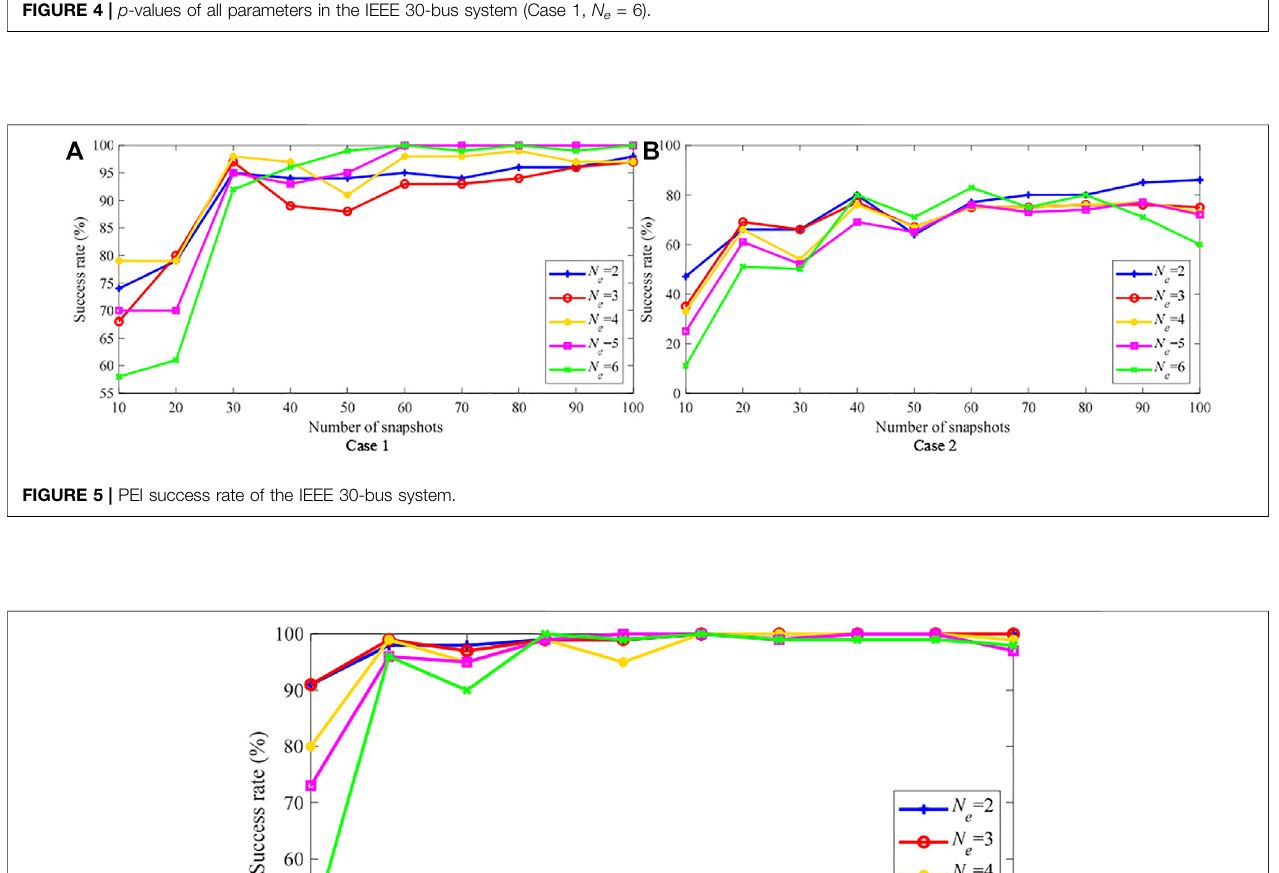
Frontiers in Energy Research |